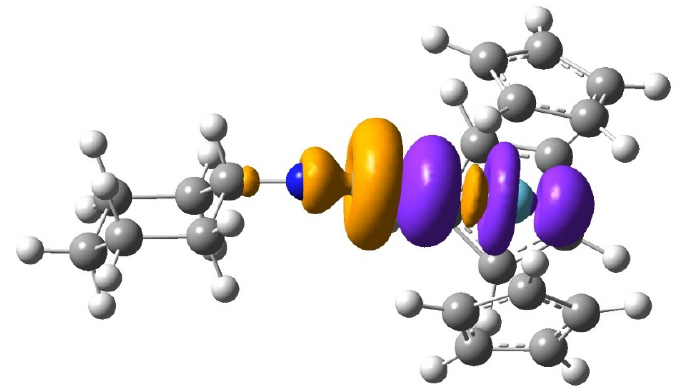
Figure 8. The NOCV pair (isovalue = 0.0004 au) demonstrating the σ -donation CyN ≡ C → 5d 0 orbital of La in the (Cp) 3 La(C ≡ NCy) complex. The colors orange and violet mean the donated and accepted densities, respectively.